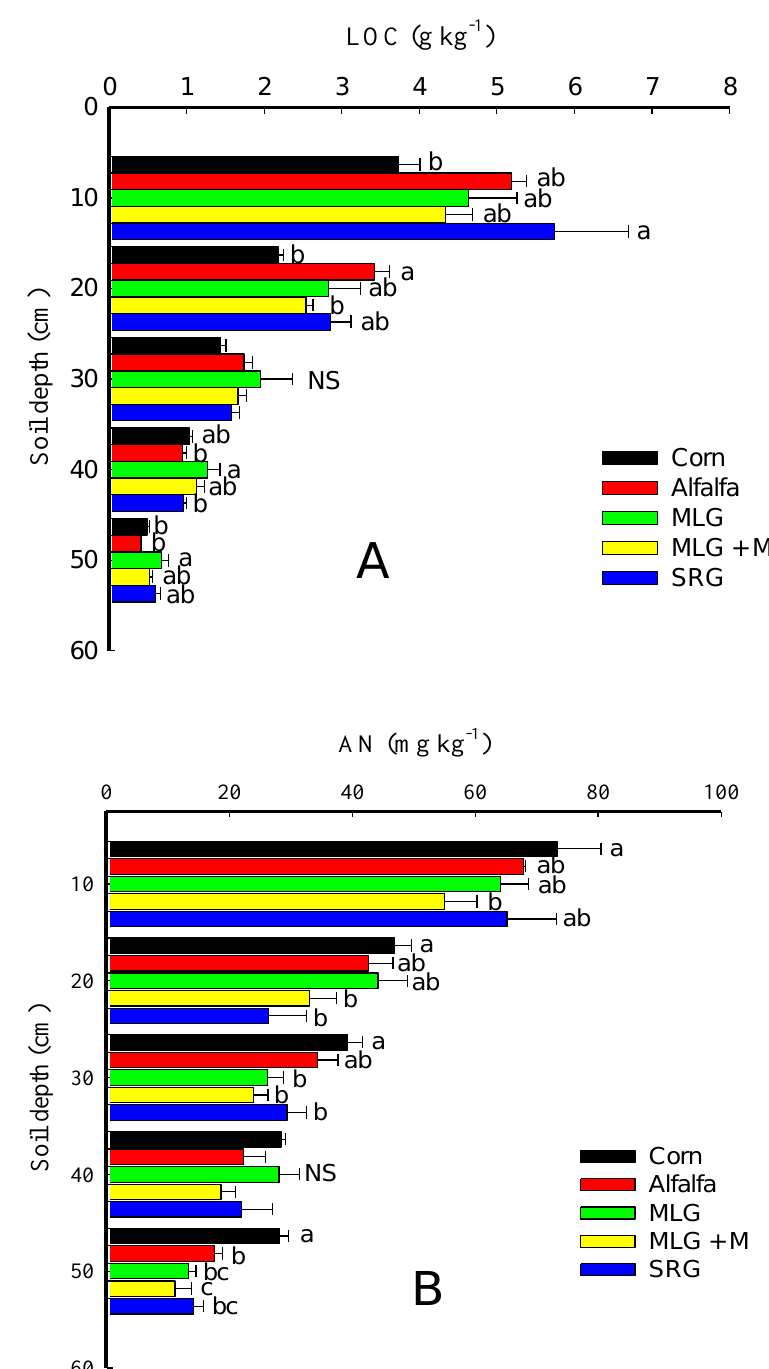
Figure 4. Mean values of labile oxidizable carbon (LOC) ( A ) and available nitrogen (AN) ( B ) under different land uses. The bars represent standard errors. Values without a common letter within land use treatments differed according to the LSD test ( p < 0.05). NS = not significant among different land uses. See Figure 2 for the abbreviations.